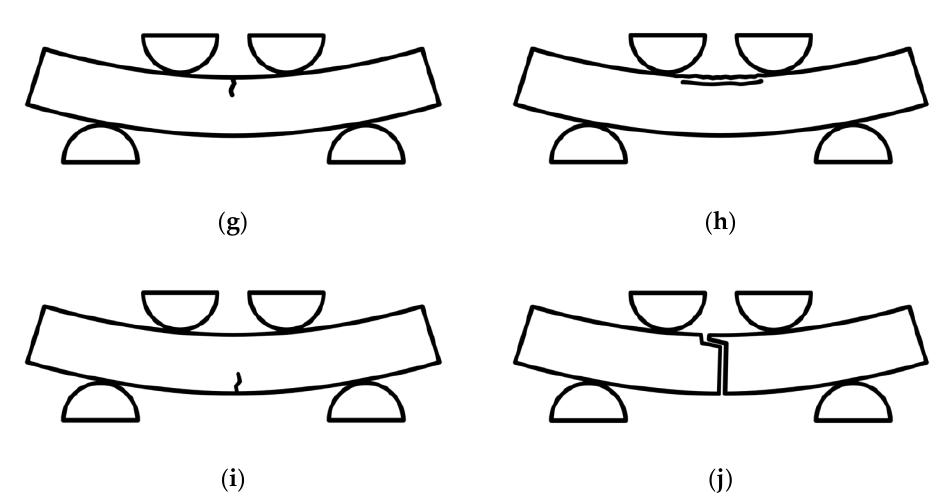
Figure A1. Failure modes in the four-point bending tests. The naming of the failure type matches the label of the subfigure. ( a ) Fiber fracture triggered by tensile stresses resulting in fibers sticking out of the sample surface in the lower center; ( b ) matrix cracking and local fracture triggered by tensile stresses opposite to the upper load induction; ( c ) matrix cracking and local fracture triggered by compression at the upper load induction points; ( d ) fracture triggered by interlaminar shear and tensile stresses at the bottom center; ( e ) fracture triggered by interlaminar shear and compression stresses at the top; ( f ) fracture triggered by interlaminar shear stresses at the sample middle; ( g ) matrix cracking and local fracture triggered by compression at the upper center; ( h ) fracture triggered by compression at the surface between the upper load induction points; ( i ) matrix cracking and local fracture triggered by tensile stresses in the lower center; ( j ) fracture of the whole sample triggered by tensile stresses in the lower